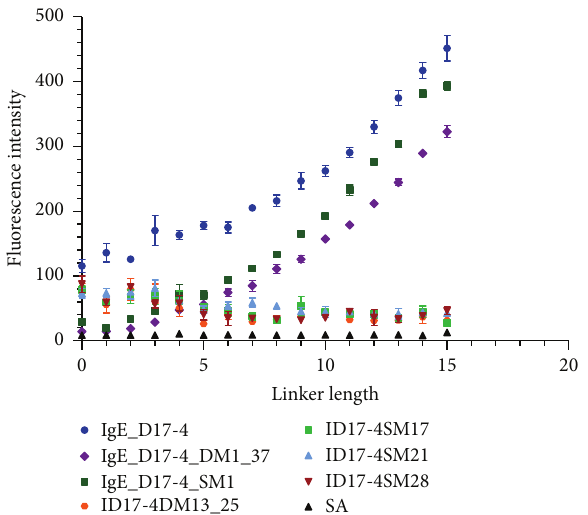
Figure 2: Response of different T linker sequences to 100nM Cy3- IgEin PBSMTBbuffer. Errorbarsrepresent SEMofrawfluorescence intensity values for 5–15 replicates of each sequence.